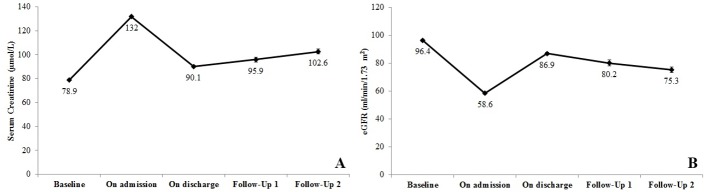
Mean values of serum creatinine (A) and eGFR (B) with standard errors in patients with AKI during follow-up periods (On admission, after 6 weeks (follow-up 1) and after 12 weeks (follow-up 2).